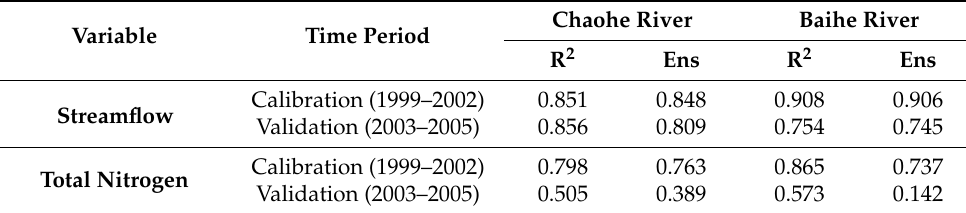
Table 3. Performance of the Soil and Water Assessment Tool (SWAT) simulation in the